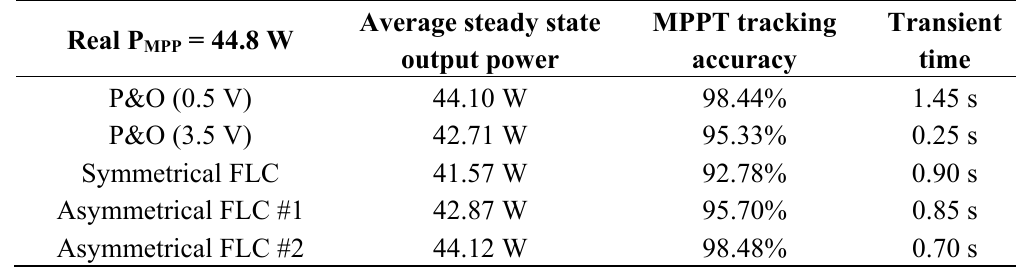
Table 5. Summarized experimental performance of different methods (200 W/m 2 test case).